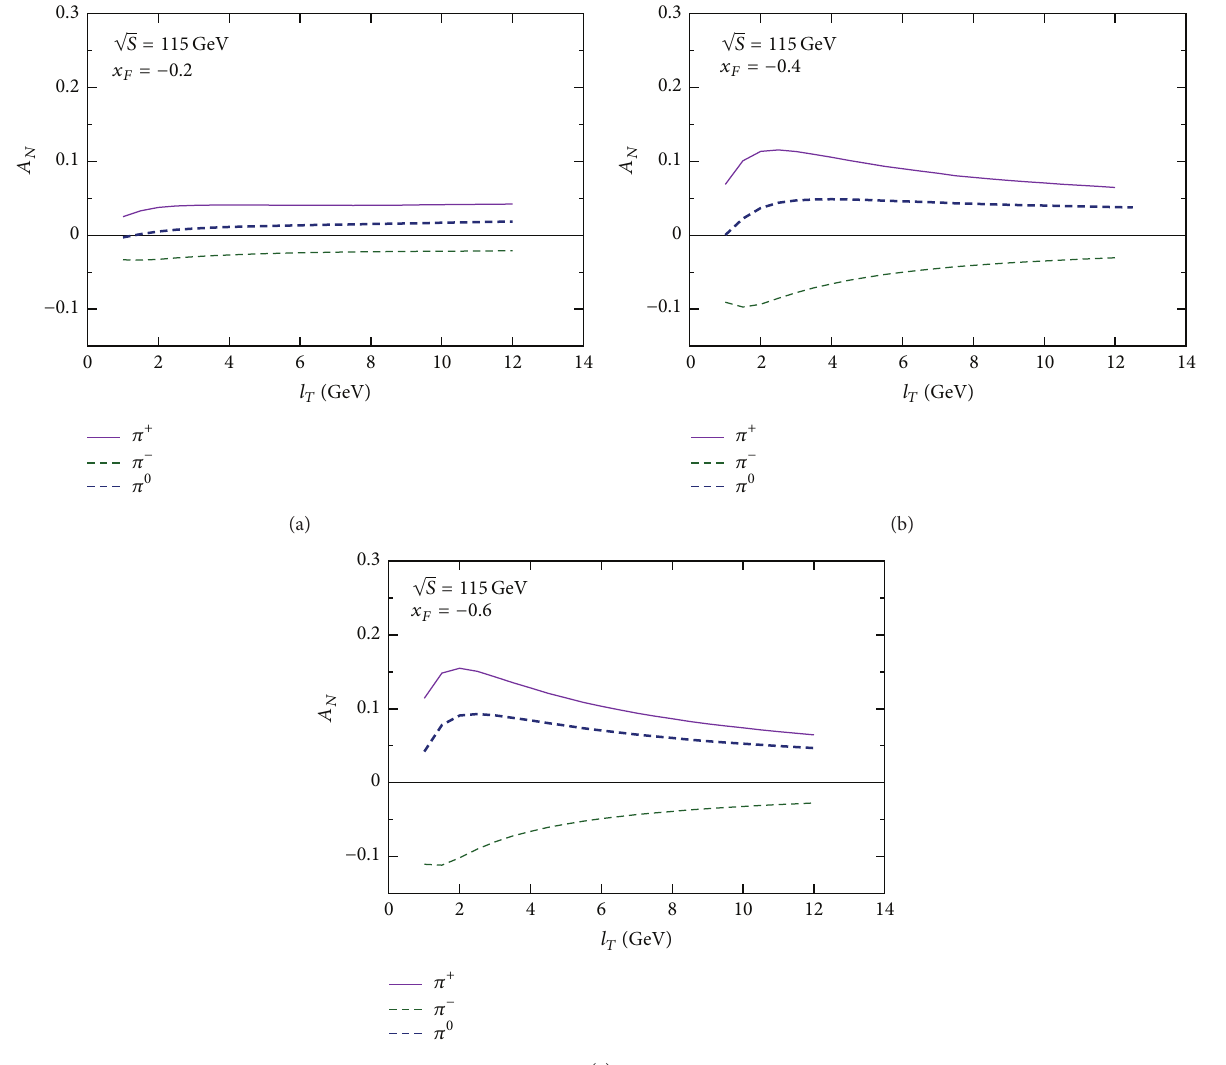
Figure 2: 𝐴 𝜋 𝑁 versus 𝑙 𝑇 at fixed 𝑥 𝐹 = −0.2 (a), 𝑥 𝐹 = −0.4 (b), and 𝑥 𝐹 = −0.6 (c) at √𝑆 = 115 GeV for pion production at